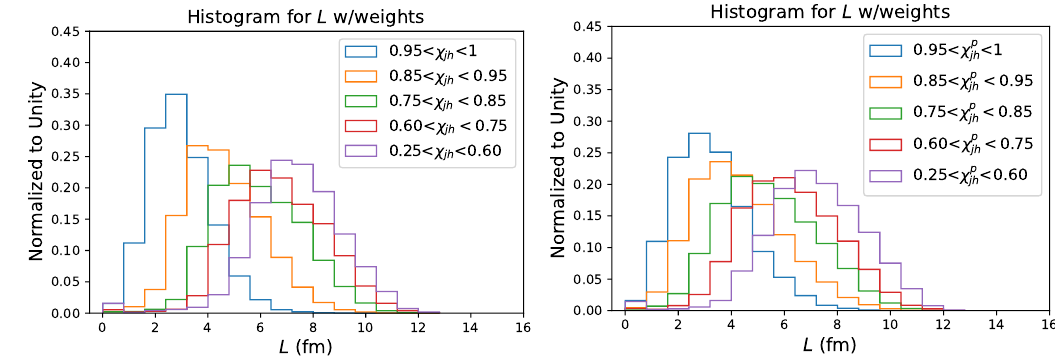
Figure 18 . Left: distributions for the length traversed in the QGP of jets within different ranges of the true value of χ . Right: same as left panel, but using the predicted value χ p jh